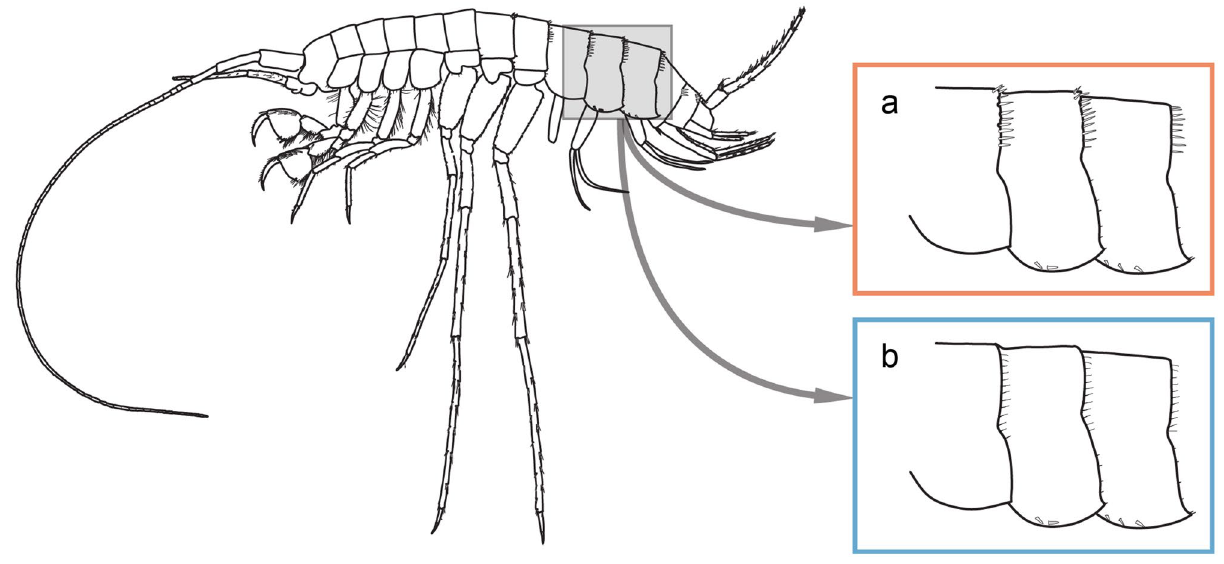
Figure 1. A representative of the lake ecomorph ( Niphargus croaticus ; modified from the previous publication 20 ). ( a ) A close-up of the pleon in spined lake Niphargus species, with a series of spines along the edge of the segments. ( b ) The same part of the pleon as in non-spined lake Niphargus species, with soft and thin setae along the edge of the